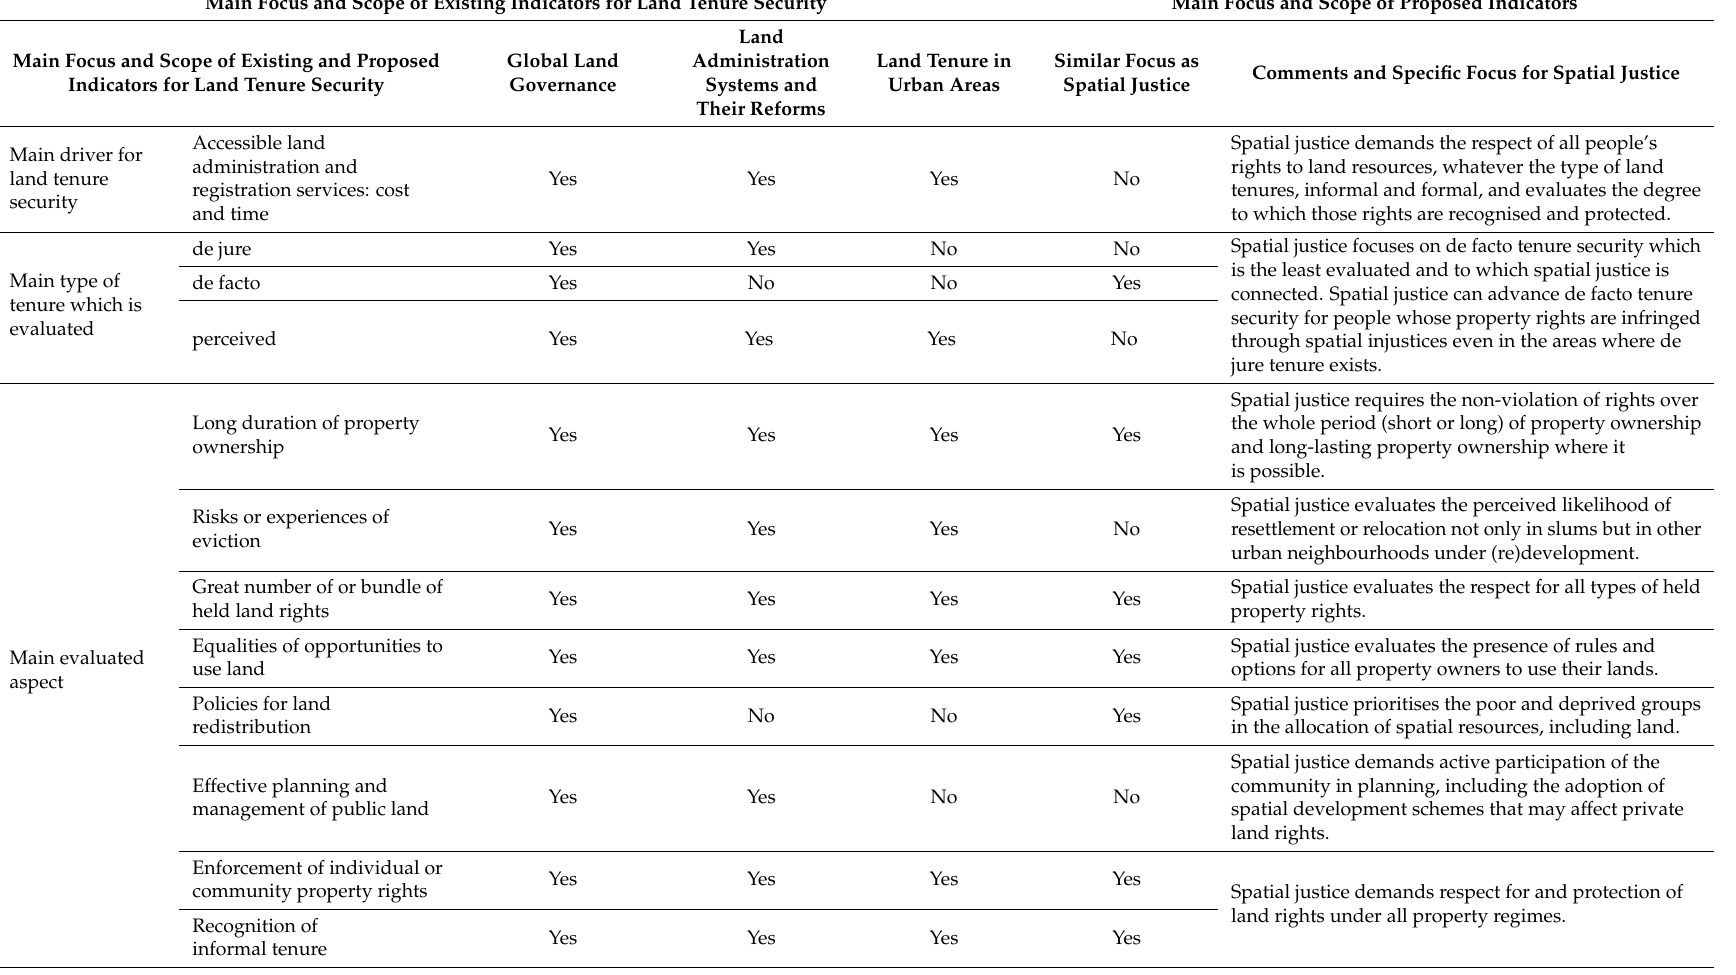
Table 1. The central focus of the existing and proposed land tenure security